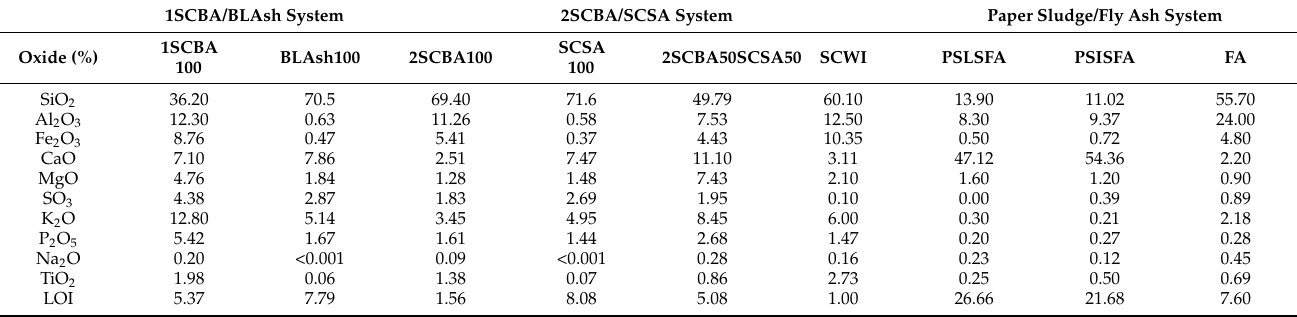
Table 2. Chemical composition of the binary pozzolanic